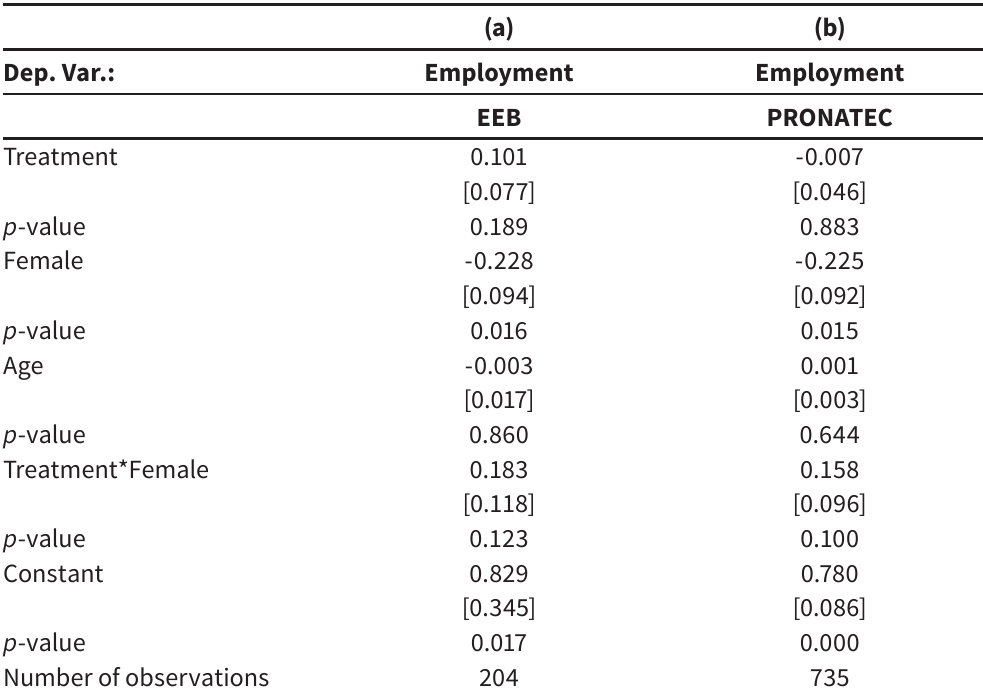
OLS Estimates of the Correlation between the Treatment and Labor Market